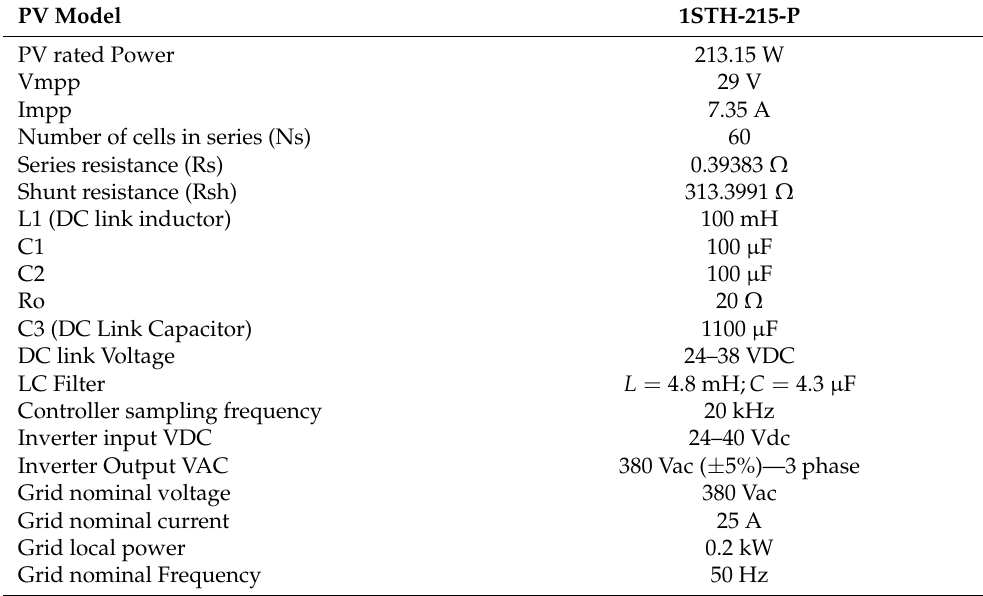
Table 2. Specification of the proposed